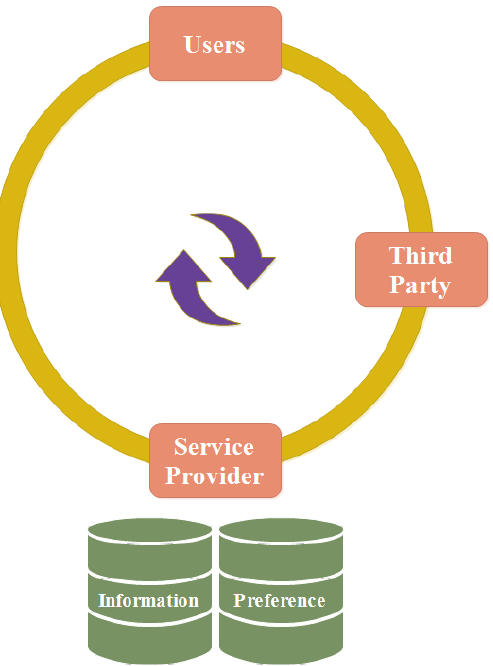
Figure 15. Preference based privacy protection system for